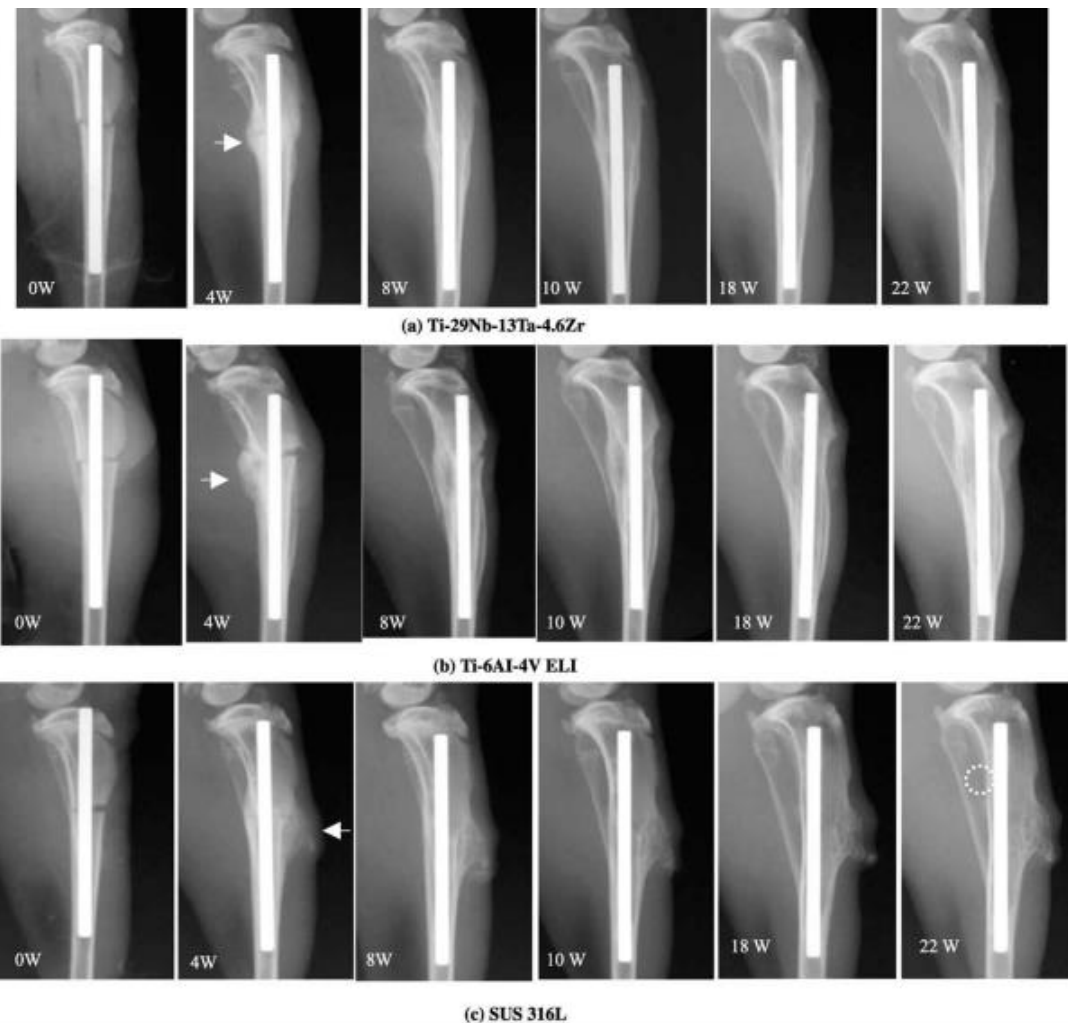
Figure 7. X-ray used to track the healing of a bone fracture from the time of surgery until 22 weeks later. Callus development is shown by the arrow, and atrophic alteration is indicated by the dotted round mark. Adapted with permission from [273]. 2022.